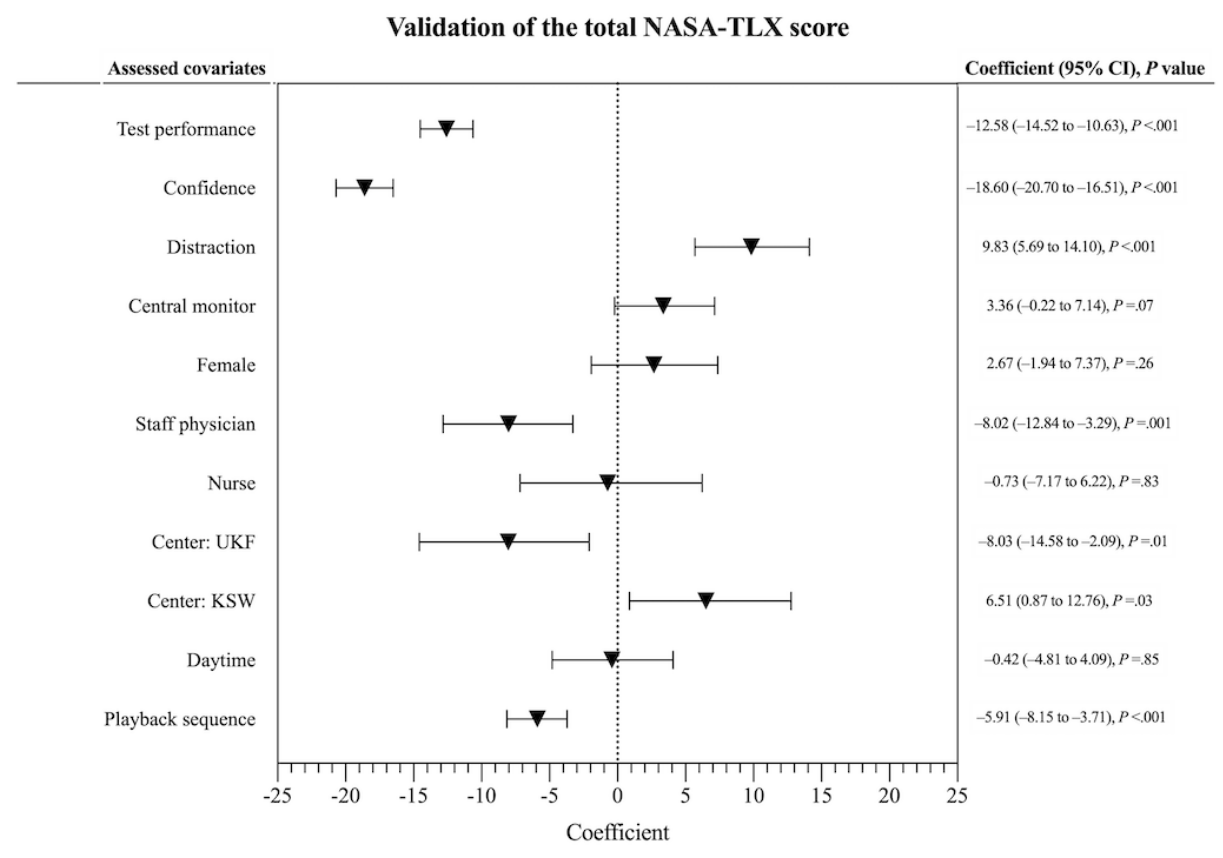
Figure 2. Correlation of different covariates with the total score of the National Aeronautics and Space Administration Task Load Index (NASA-TLX) workload assessment tool. Left and right of the dashed line indicate lower and higher perceived workload, respectively. KSW: Cantonal Hospital Winterthur; UKF: University Hospital